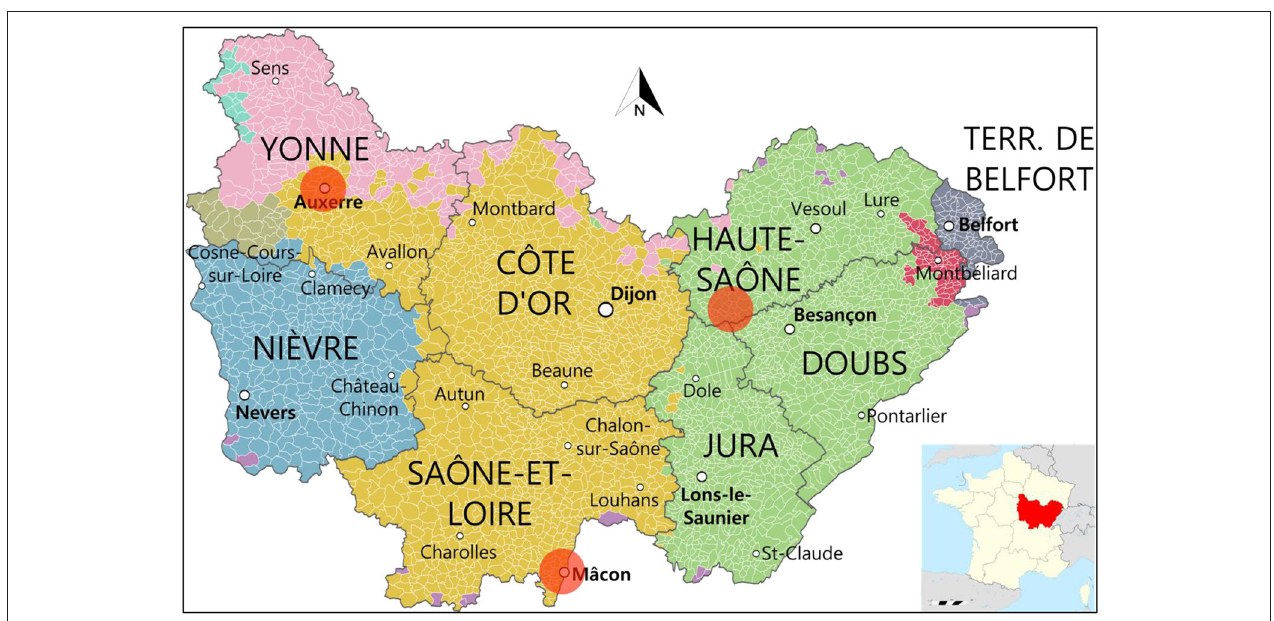
FIGURE 1 | Map of Bourgogne Franche-Comté region of France and the locations of the study sites (red dots). Source: